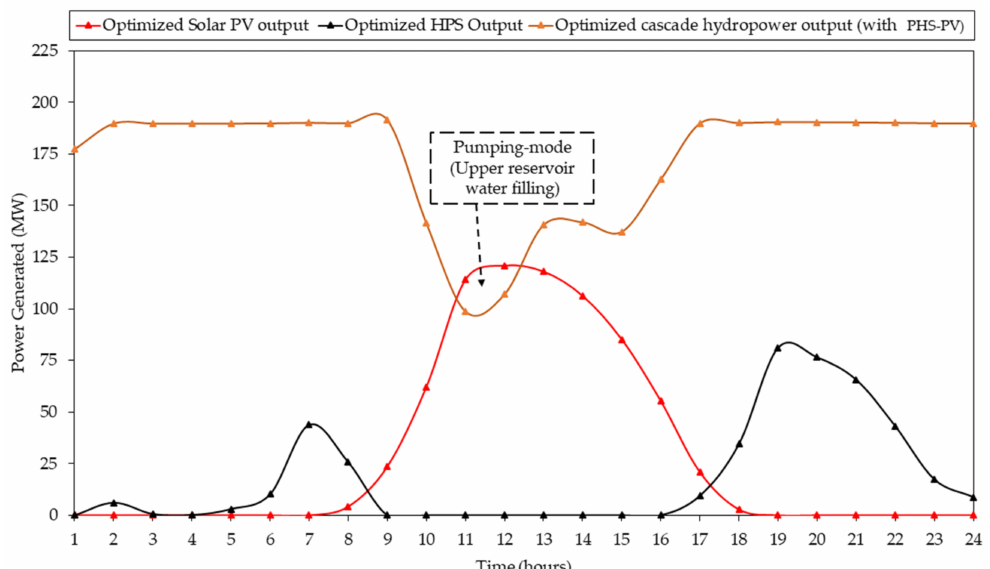
Figure 11. Combined optimized power